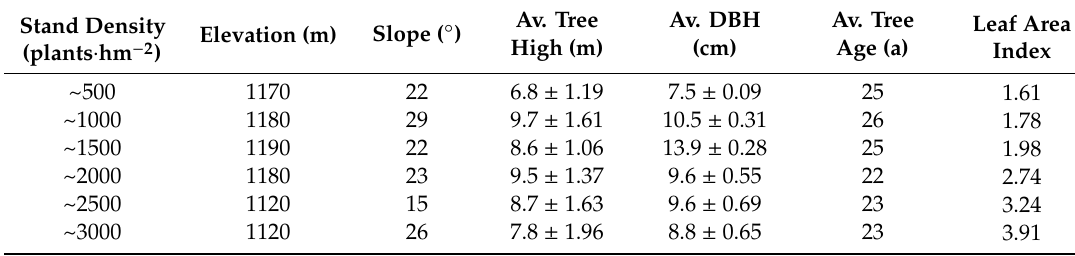
Table 1. Basic information on standard R. pseudoacacia